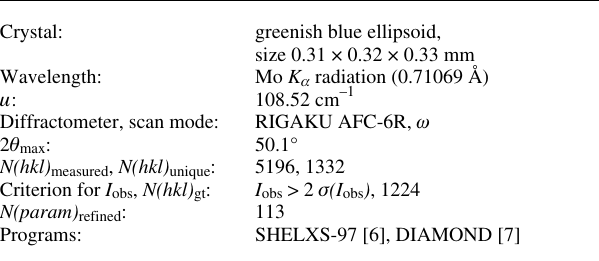
Table 10. Data collection and handling. Table 11. Atomic coordinates and displacement parameters (in Å 2 ) .